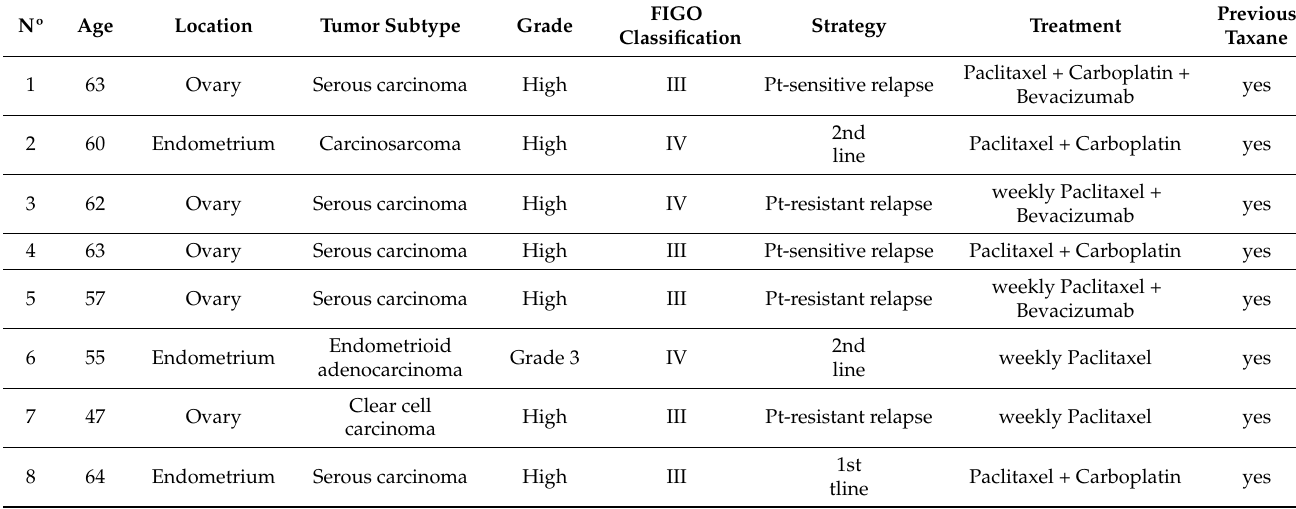
Table 1. Patients’ clinical features.